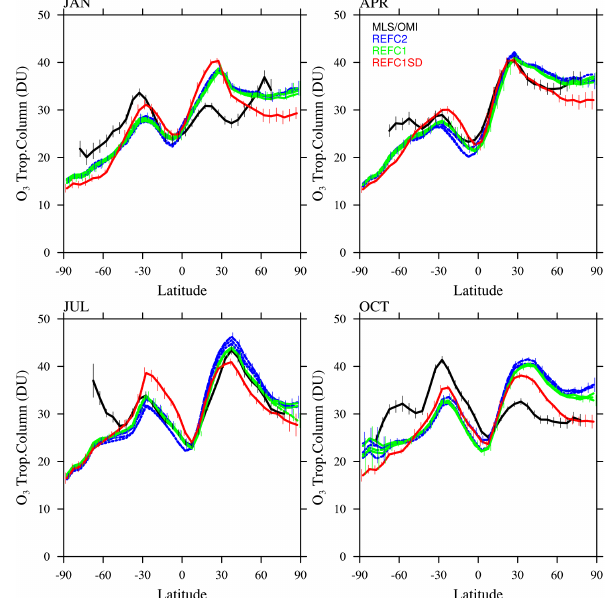
Figure 7. Monthly and zonally averaged tropospheric ozone col- umn (in DU) comparison between OMI/MLS observations (black) and different model experiments; see legend (for ozone < 150ppb in the model) for 4 months. Error bars describe the zonally aver- aged 2 sigma 6-year root mean square standard error of the mean at a giving grid point, derived from the 10 ◦ N to 10 ◦ S gridded prod- uct (Ziemke et al., 2011). Model results are interpolated to the same grid and error bars indicate the standard deviation of the interannual variability per latitude